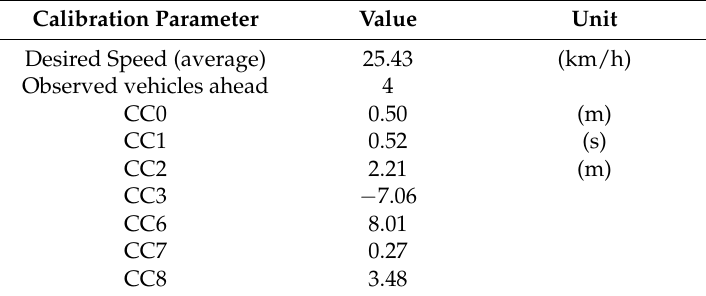
Table 1. Car following